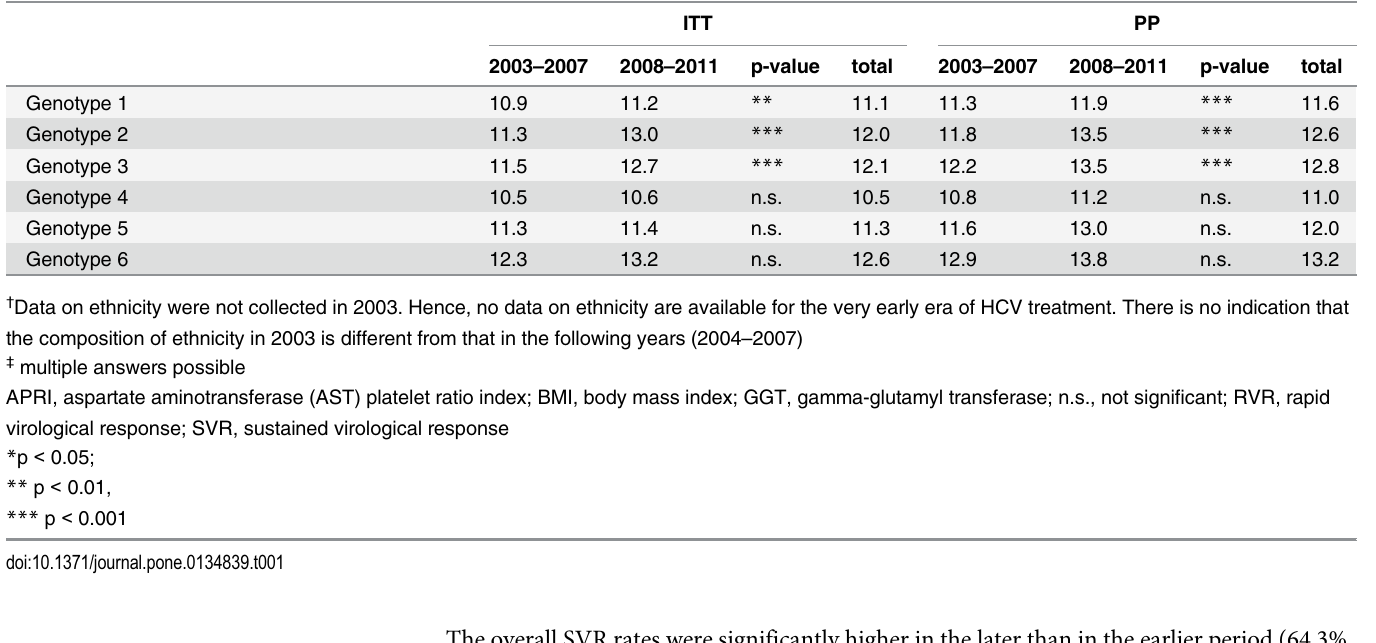
The overall SVR rates were significantly higher in the later than in the earlier period (64.3% versus 61.2%; p = 0.008). The SVR rates in patients with genotype 1 infection were 51.9% in the earlier years versus 56.3% in the later years (p = 0.0057). For genotype 3 infected patients SVR rates showed no statistical difference (80.5% versus 81.0%, p = 0.8070). For genotype 2